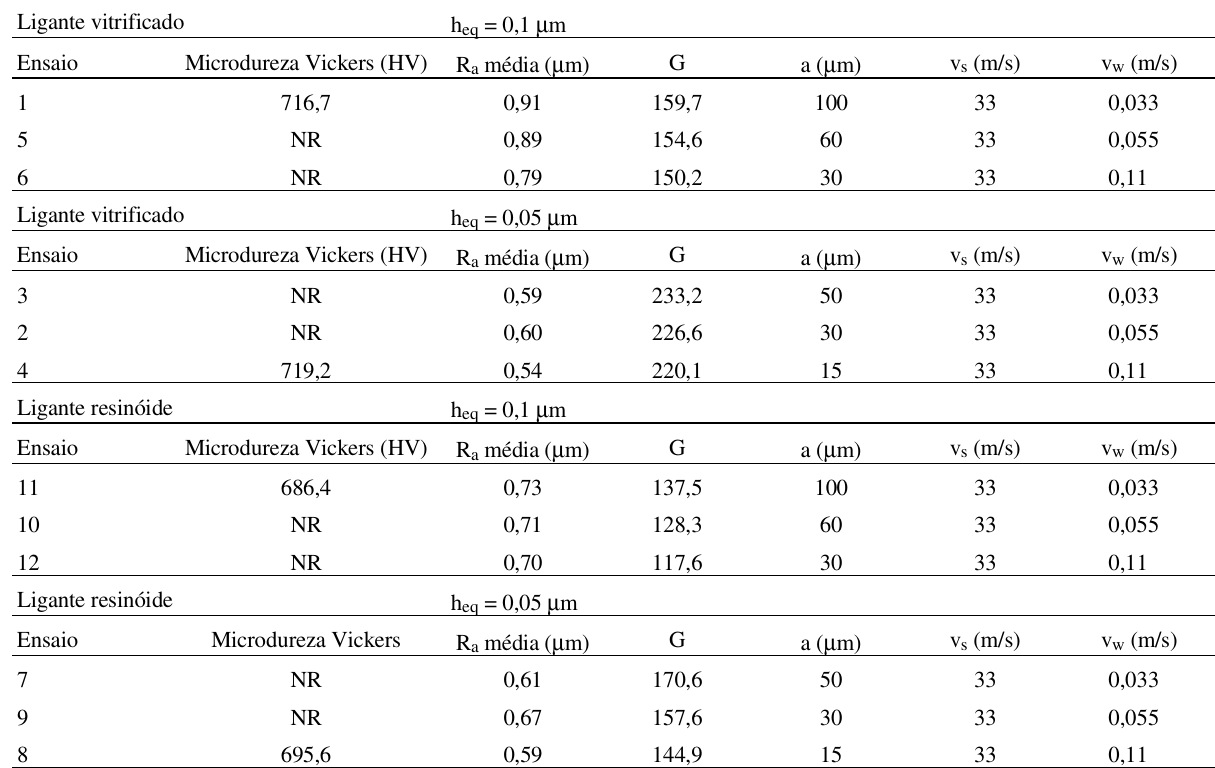
Table 1. Condições de usinagem e valores de rugosidade R a dos rebolos de CBN com ligantes vitrificado e resinóide. Ligante